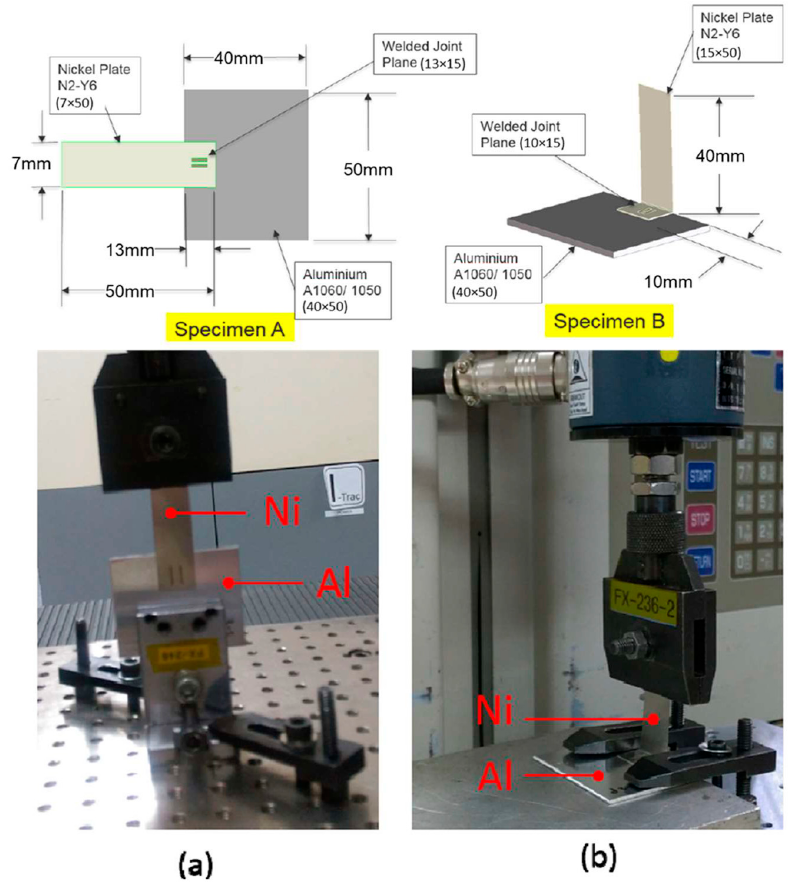
Figure 2. Weld strength testing set-ups: ( a ) shear test; ( b ) 90-degree peel